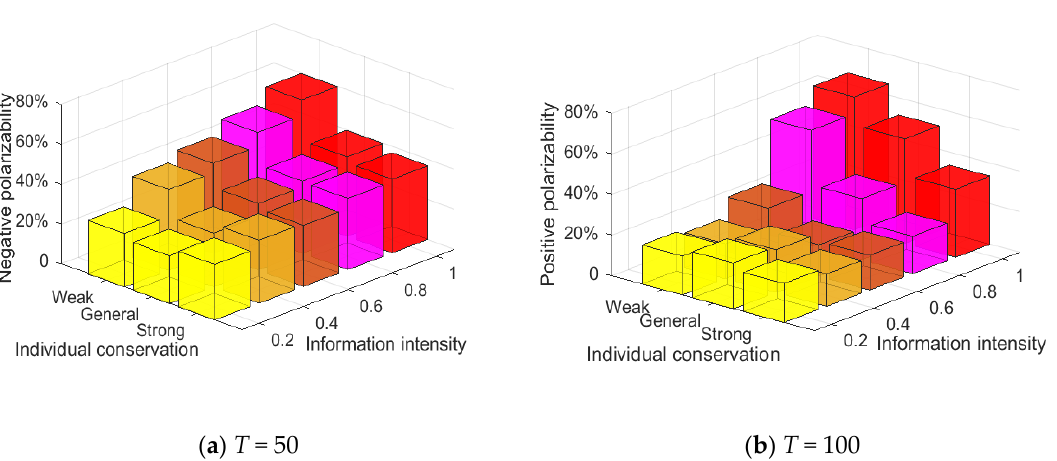
Figure 20. Relationship between information intensity, individual conservation and attitude